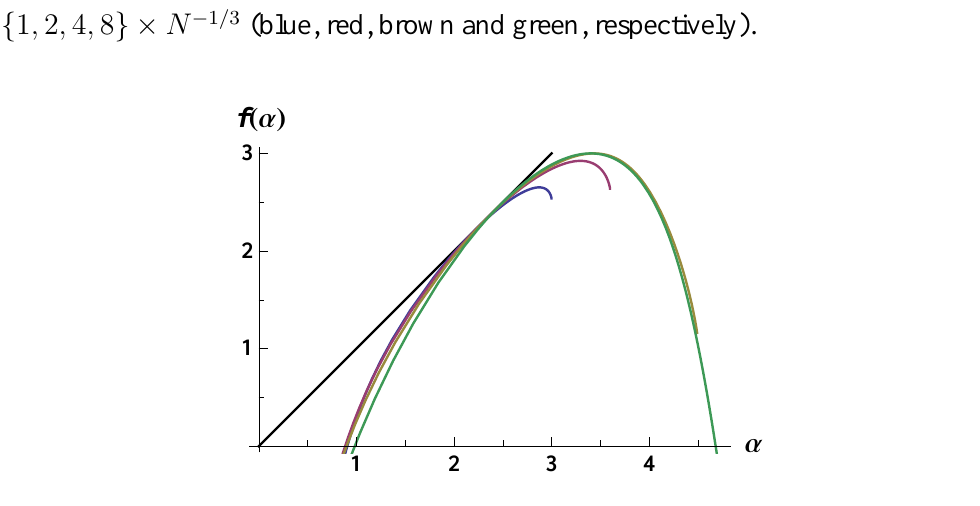
Figure 6. Multifractal spectra of the dark matter in the Mare Nostrum simulation, for r = { 1 , 2 , 4 , 8 } × N − 1 / 3 (blue, red, brown and green,